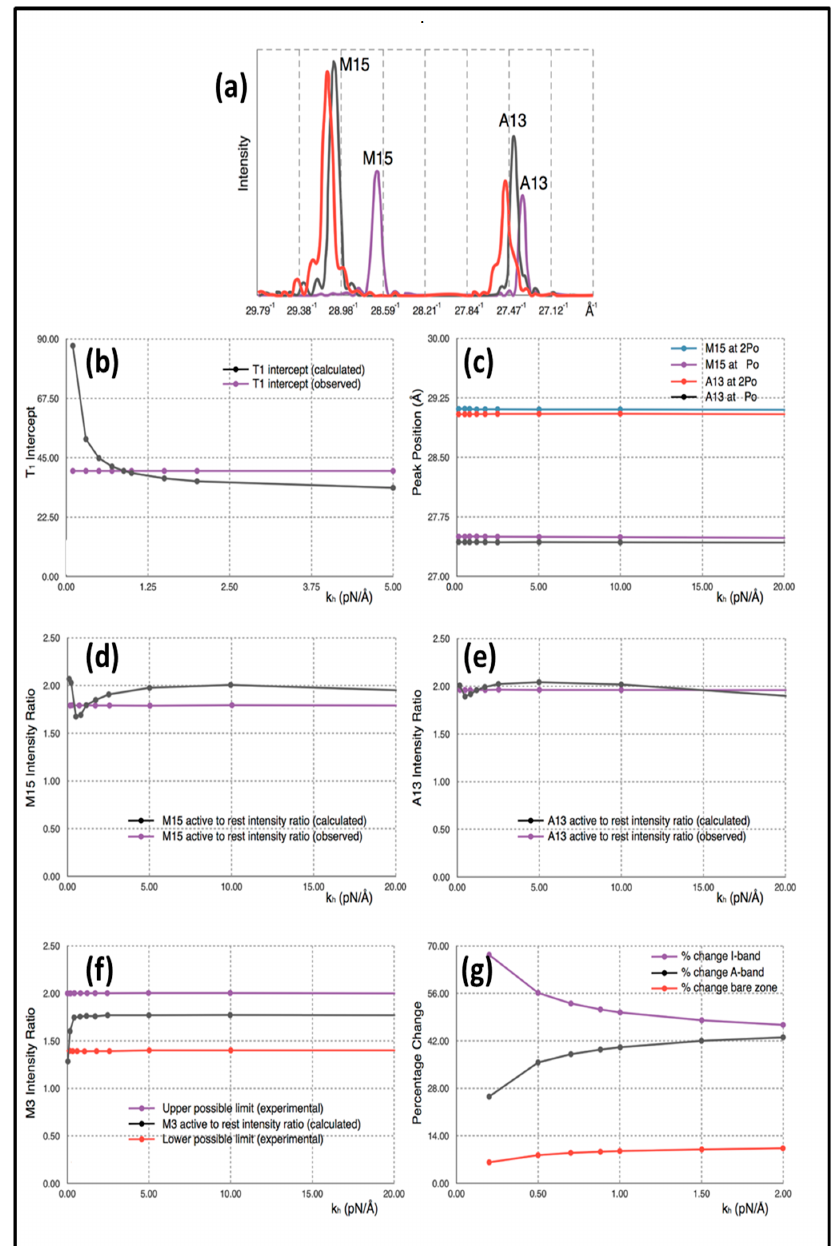
Figure 4. ( a ) Example of the computed X-ray profiles from calculations using Model 3. The purple curve is calculated from a resting muscle, the black curve from a muscle subject to a P o = 480 pN external force and the red curve from a muscle subjected to a 2P o external force. ( b ) Black curve: Changes of the T 1 intercept as a function of the head stiffness k h , with the filament stiffnesses held constant. Purple curve: observed value of the Table 1 intercept (taken as 40Å). ( c ) M15 and A13 peak Positions as a function of head stiffness as calculated from the simulated X-ray diffraction from Model 3 after subjecting them to a P o and 2P o external force. ( d ) Black: M15 active to rest intensity ratio as a function of stiffness as calculated from Model 3; Purple-experimental measurement. ( e ) Black: A13 active to rest intensity ratio as a function of stiffness as calculated from Model 3; Purple-experimental measurement. ( f ) Black: M3 active to rest intensity ratio as a function of stiffness as calculated from Model 3; Purple: upper limit as found experimentally; Red: lower experimental limit. ( g ) Variation of the positions of various half sarcomere features as a function of head stiffness: Purple: I-band percentage change; Black: A-band percentage change and Red: bare zone percentage change. Note the different horizontal scales in the